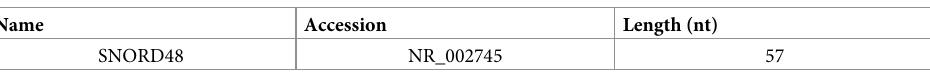
Table 2. Small nucleolar RNA used in this